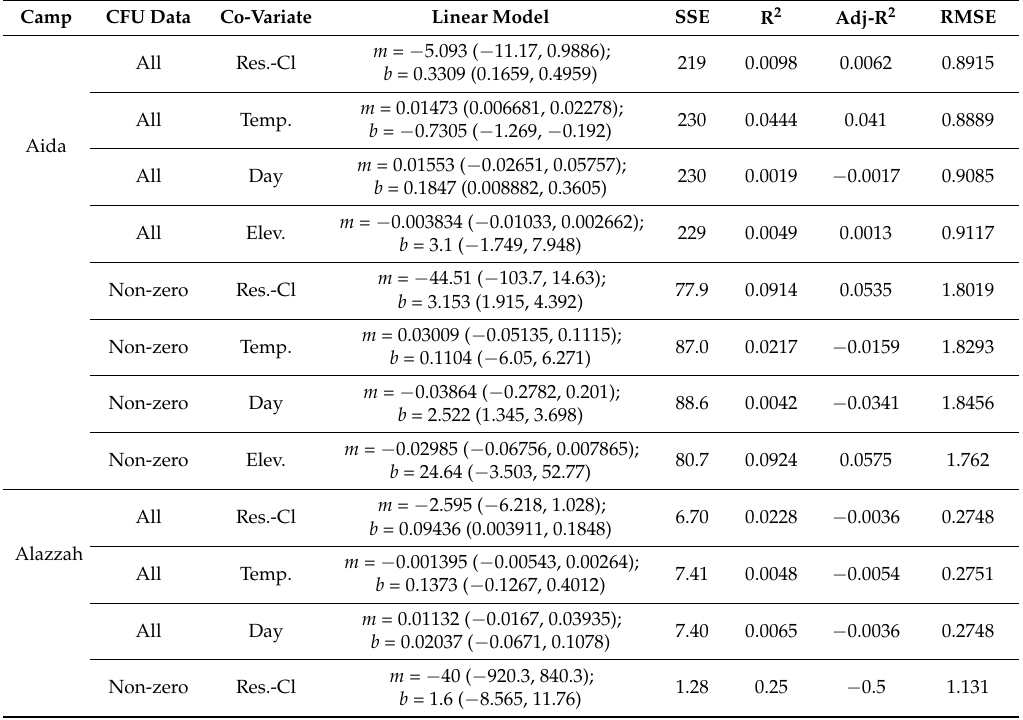
Table A1. Regression Statistics for Models in Figures A1 and